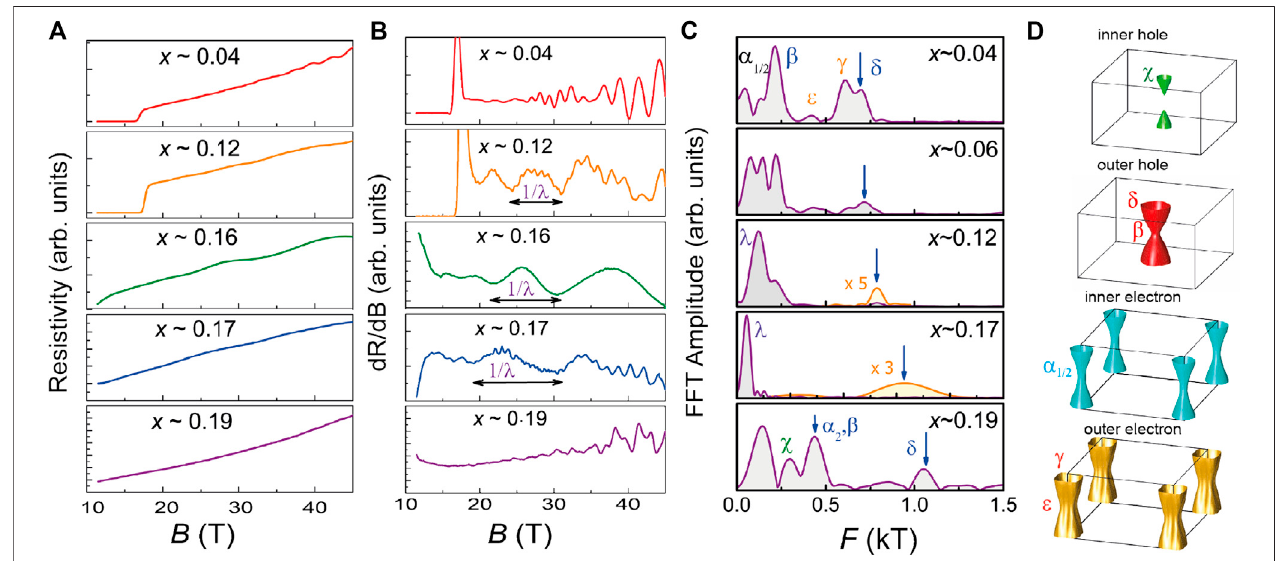
FIGURE5| QuantumoscillationsinFeSe 1 − x S x . (A) Thein-planelongitudinalresistivity ρ xx ( B )asafunctionofmagnetic fi eld B fordifferentcompositions, x ,measured at T ∼ 0.35 K (B) The oscillatory part of the resistivity visualized better by the fi rst derivative of resistivity d ρ xx /dB, as a function of magnetic fi eld from (A – F) at the lowest measured temperature. The horizontal line indicates the period of the low-frequency oscillations ( ∼ 1 / λ ) . (C) The frequency spectra of the oscillatory signal ( Δ ρ osc / ρ ) obtained by subtracting a polynomial background and using a fast Fourier transform (FFT). A multiplied FFT spectrum is used to emphasize the weak high frequency δ frequency for certain x compositions indicated by vertical arrows. The proposed Fermi surface and the different extremal areas for FeSe 1 − x S x obtained by shrinking the calculated tetragonal Fermi surface of FeSe from Figure 1E . Frequencies below 200T cannot be reliably assigned due to a possible overlap of at least 3 different small frequencies ( α 1 , α 2 , and χ ). These graphs are adapted from Ref.